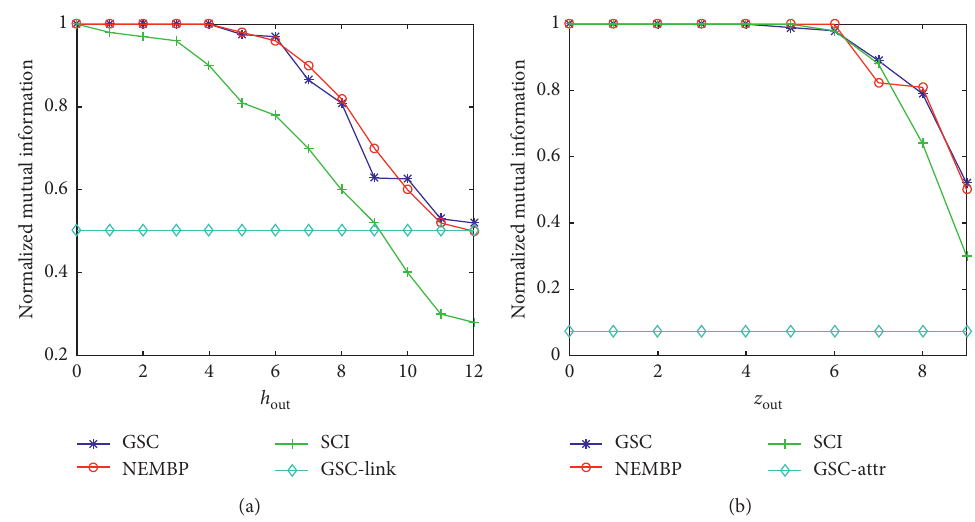
Figure 4: The value of NMI of three methods on random networks. (a) h